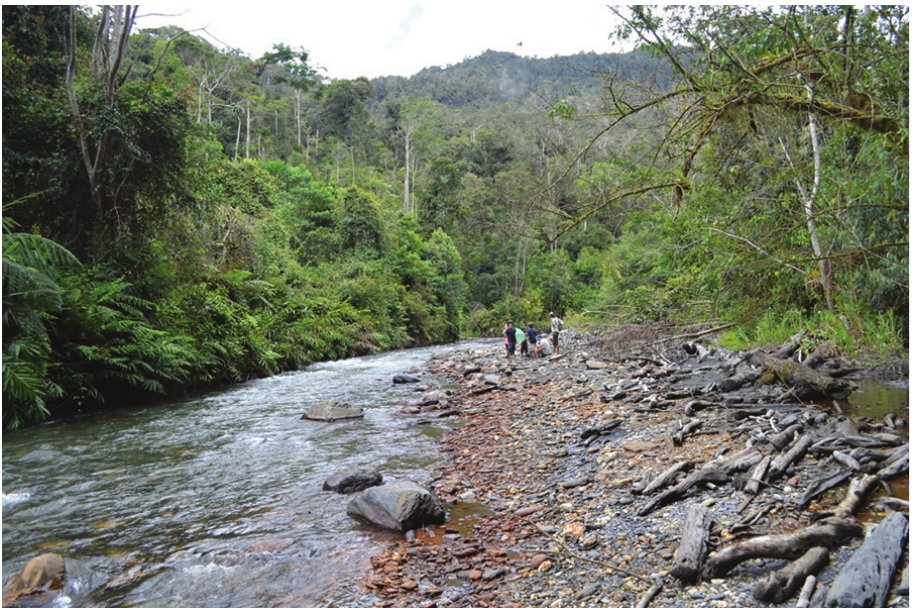
Figure 2. Wano Land, Wigoduk, Nggoduk River; photo by M.